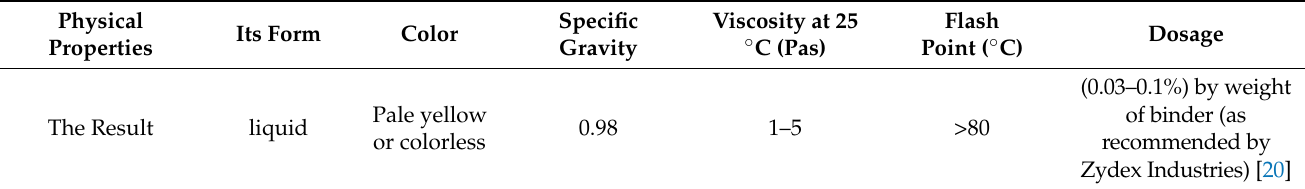
Figure 5. ZycoTherm additive.